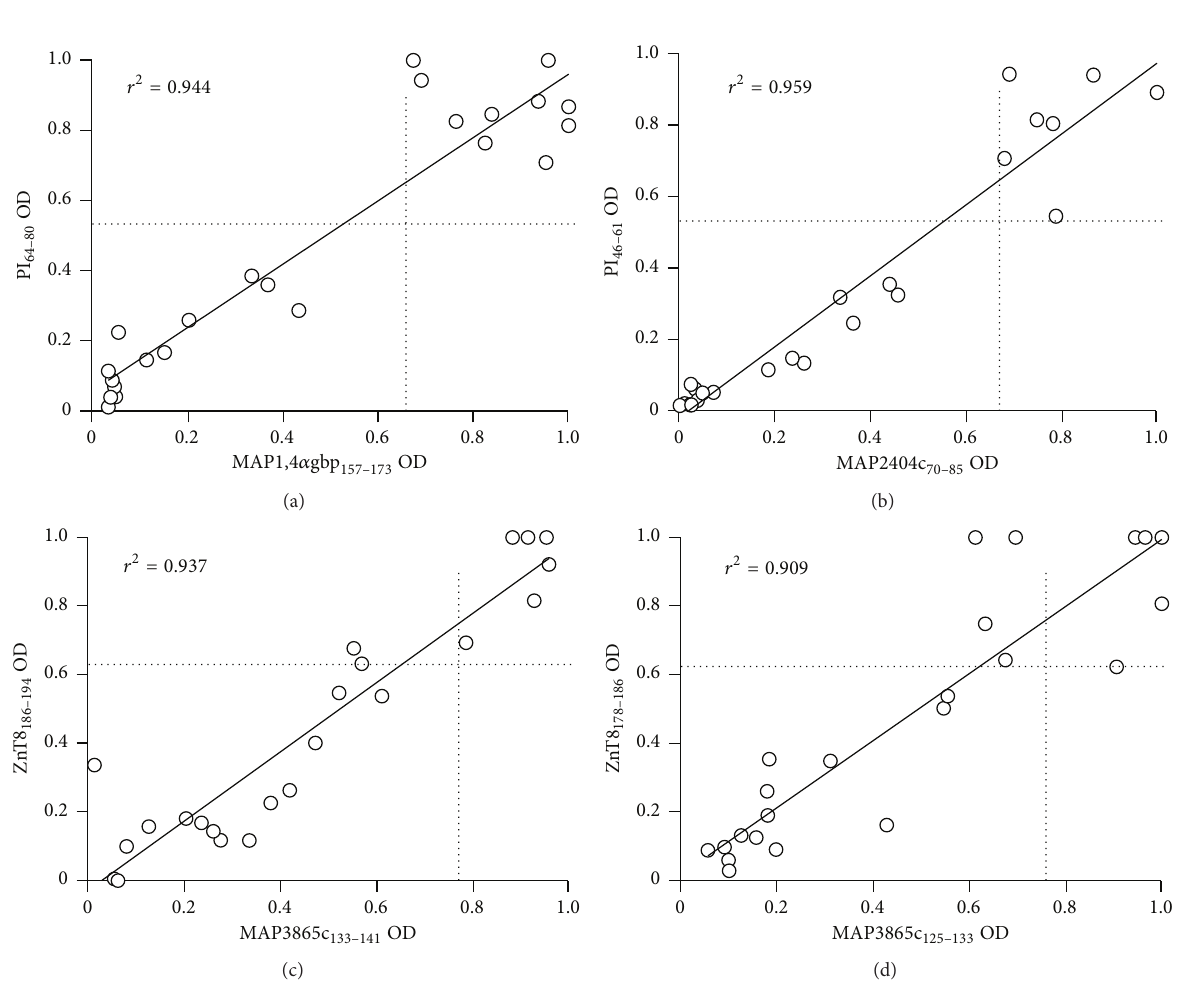
/PI 64 (a), MAP2404c 70 /PI 46 (b), MAP3865c 133 /ZnT 8 186 (c), – 173 – 80 – 85 – 61 – 141 – 194